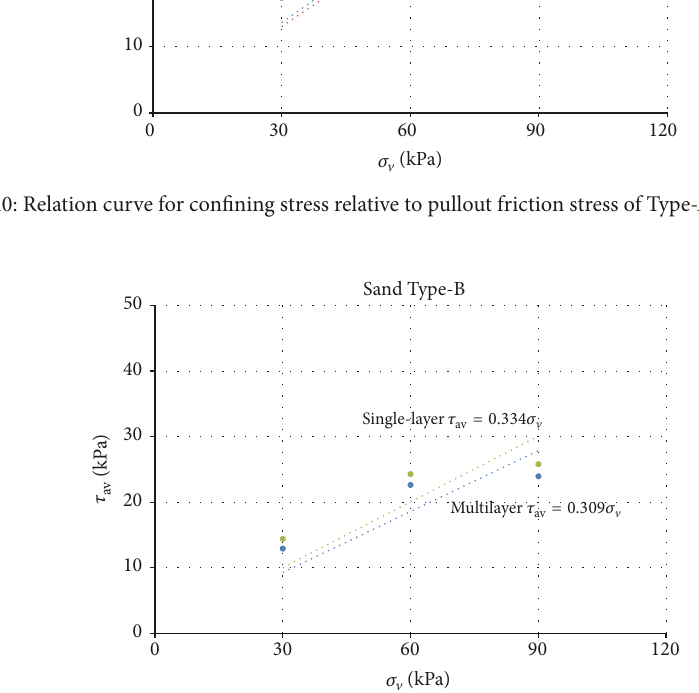
Figure 11: Relation curve of confining stress relative to pullout friction stress of Type-B